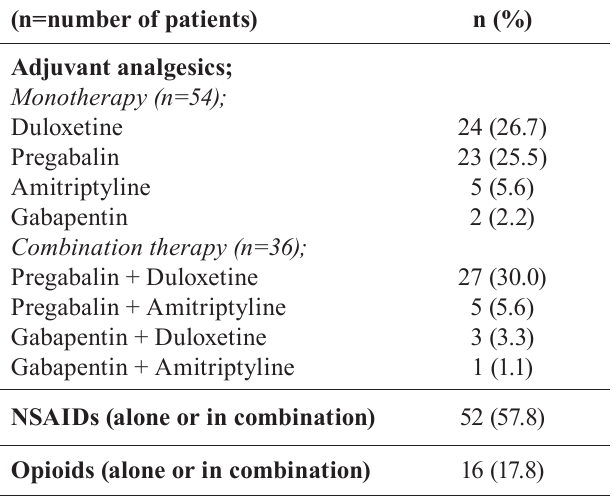
TABLE IV - Analgesic drug treatments in patients with neuropathic pain (n=number of